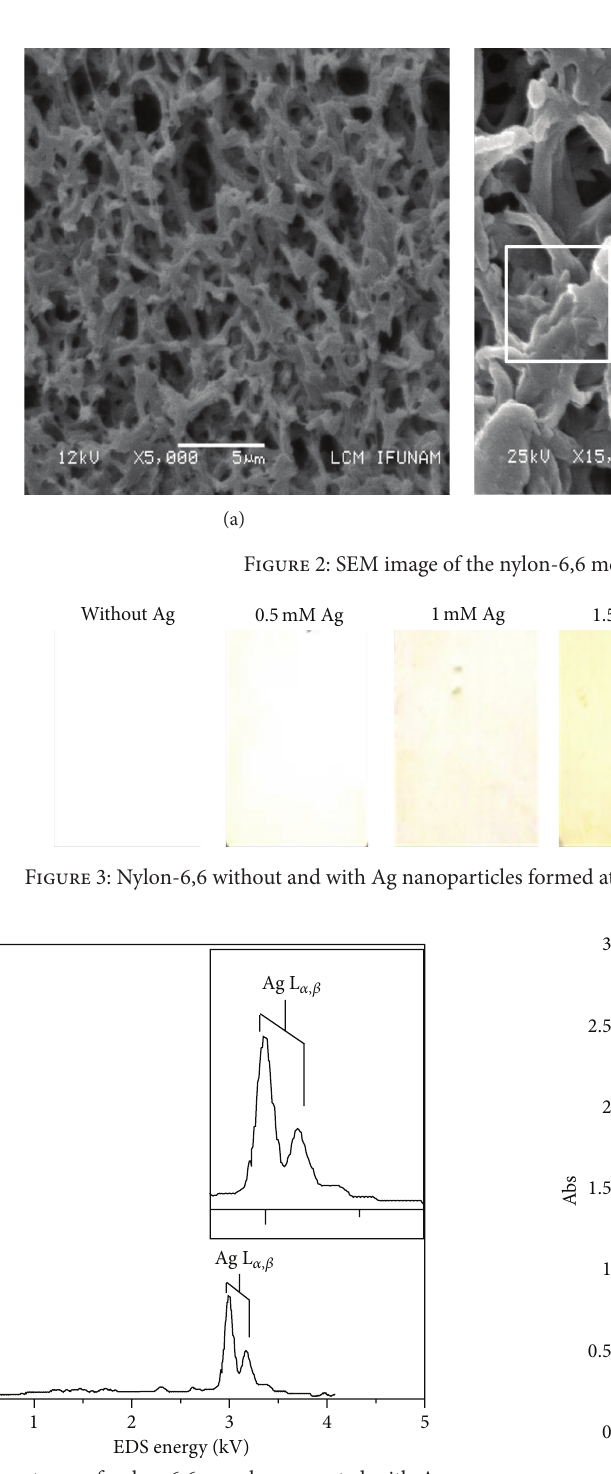
Figure 4: EDX spectrum of nylon-6,6 membrane coated with Ag nanoparticles.